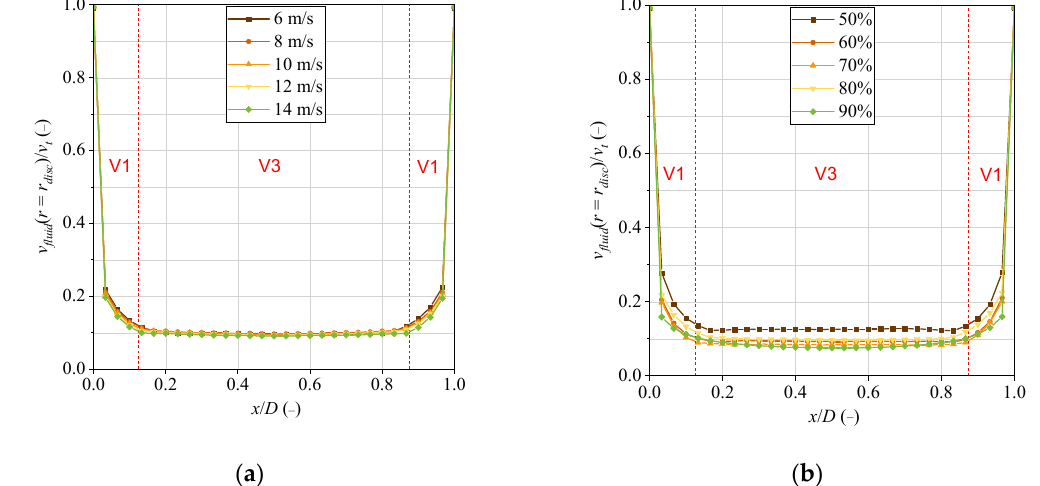
Figure 9. Average fluid velocity between the discs at the disc circumference ( r = 0.36). The red vertical lines show the border between volume V1 and V3: ( a ) for varied stirrer tip speeds; ( b ) for varied grinding media fillings.